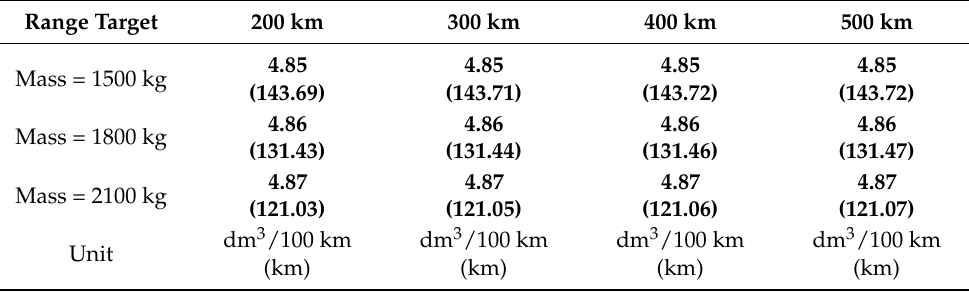
Table A14. Fuel consumption in EREV mode for constant speed drive at 130